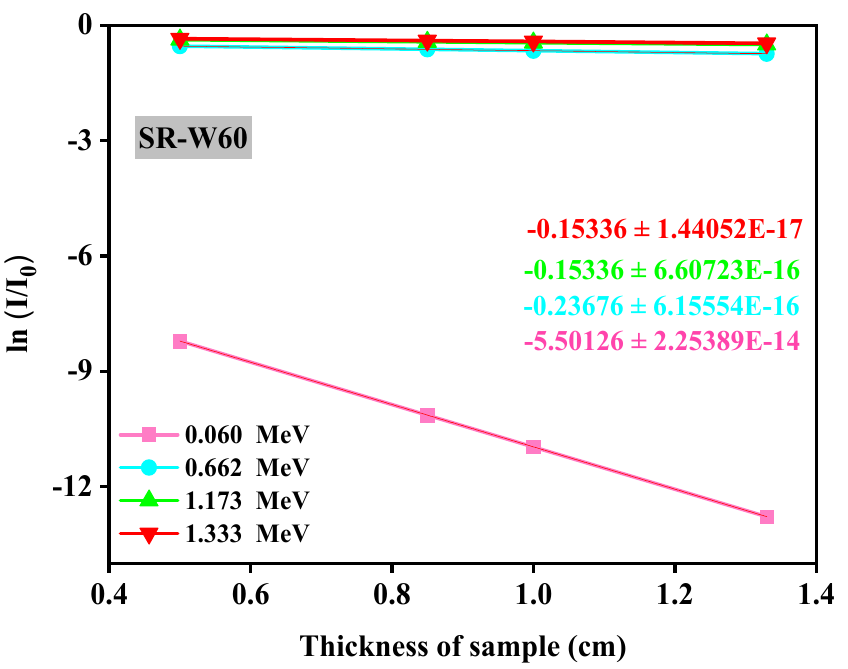
Figure 7. Diagrammatic presentation of the fractional transmission (ln(I/I 0 )) versus thickness of prepared silicone rubber sample SR-W60 system.